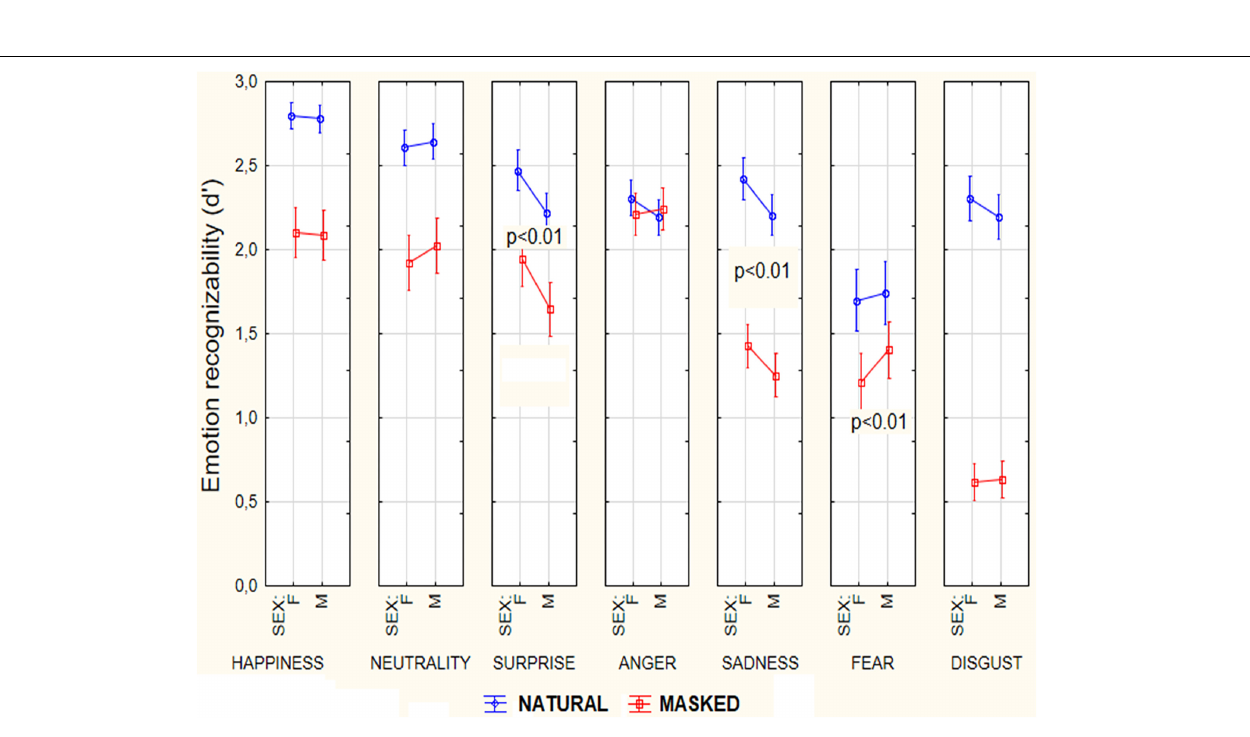
Frontiers in Neuroscience |